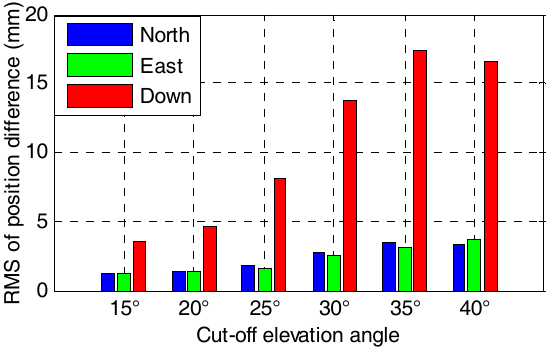
Figure 18. RMS of positioning difference of GPS/BDS/GLONASS/INS with elevation cut-off angles of